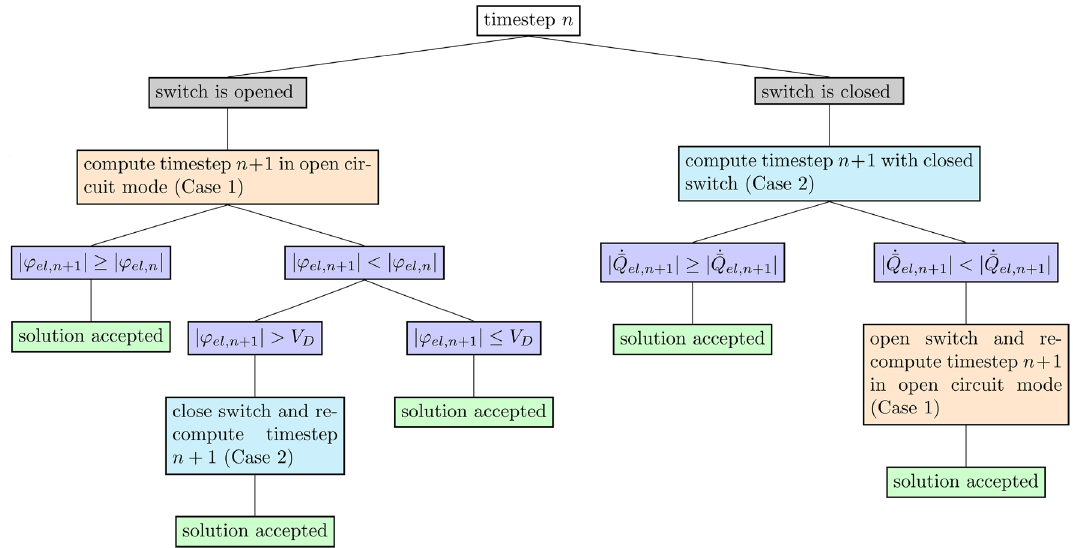
Fig. 7 Logic for the definition of boundary conditions for the FE simulation of an electromechanical structure with an SECE